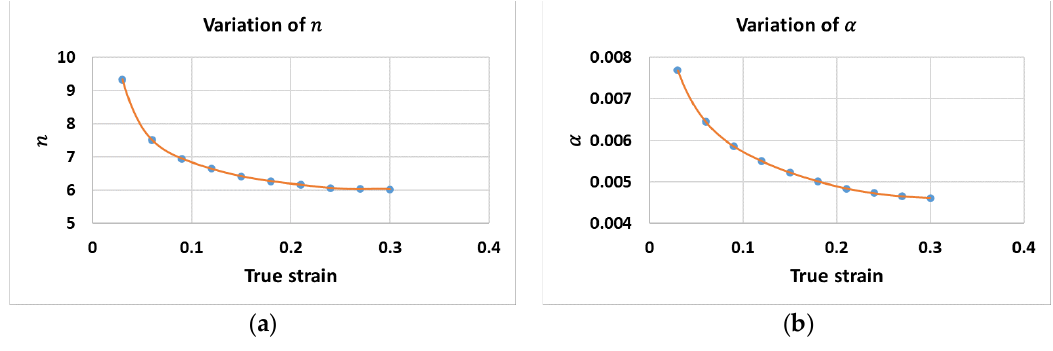
Figure 3. Variation of ( a ) n and ( b ) α .